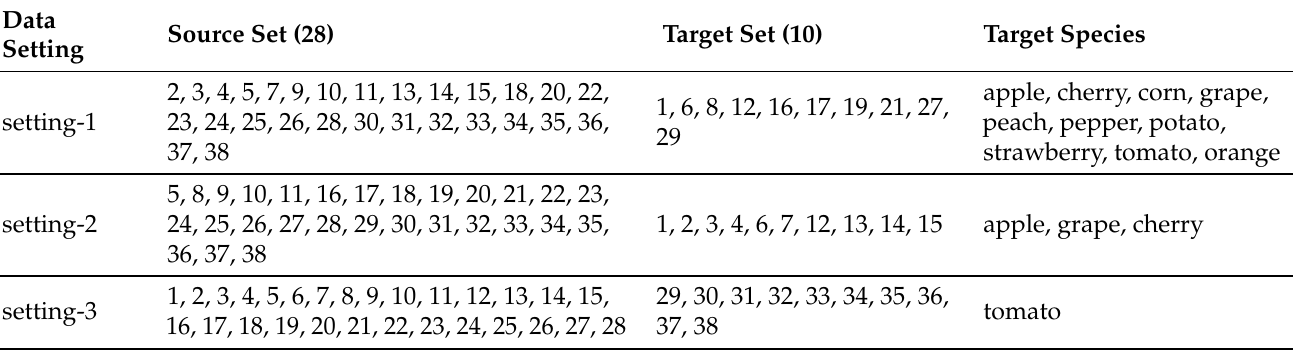
Table 10. The three data settings of PV used in our